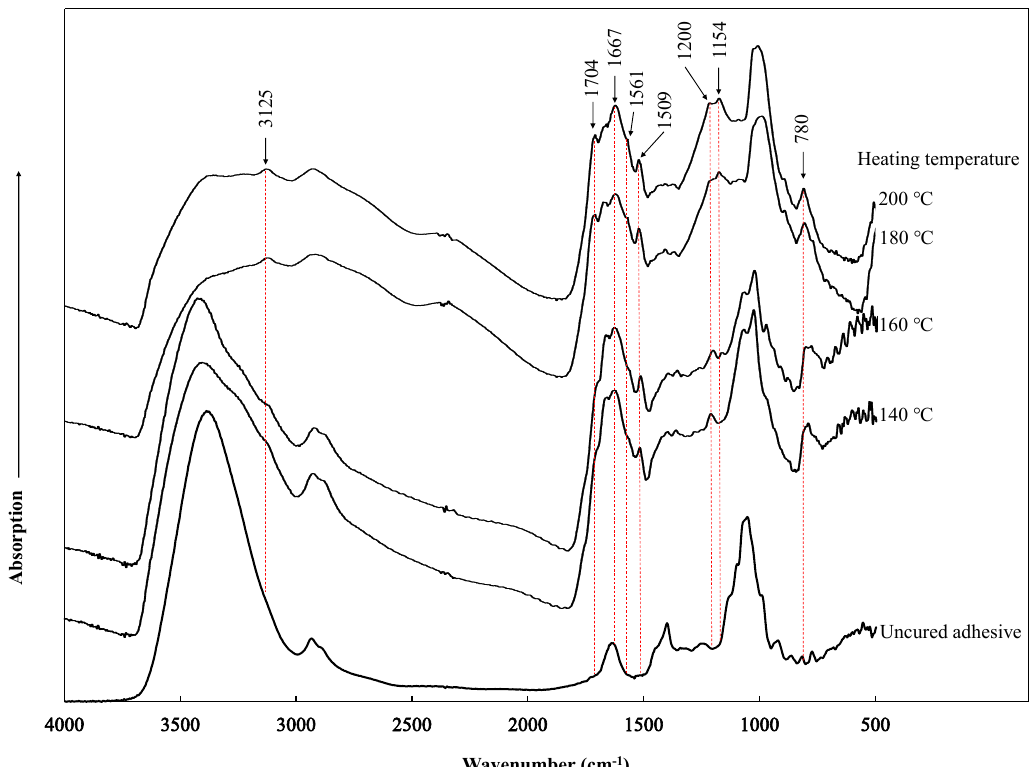
Figure 8. Infrared spectrum of the insoluble mass obtained from SADP 85/15 heated at different temperature and uncured adhesive obtained by drying at 80 °C for 15 h.